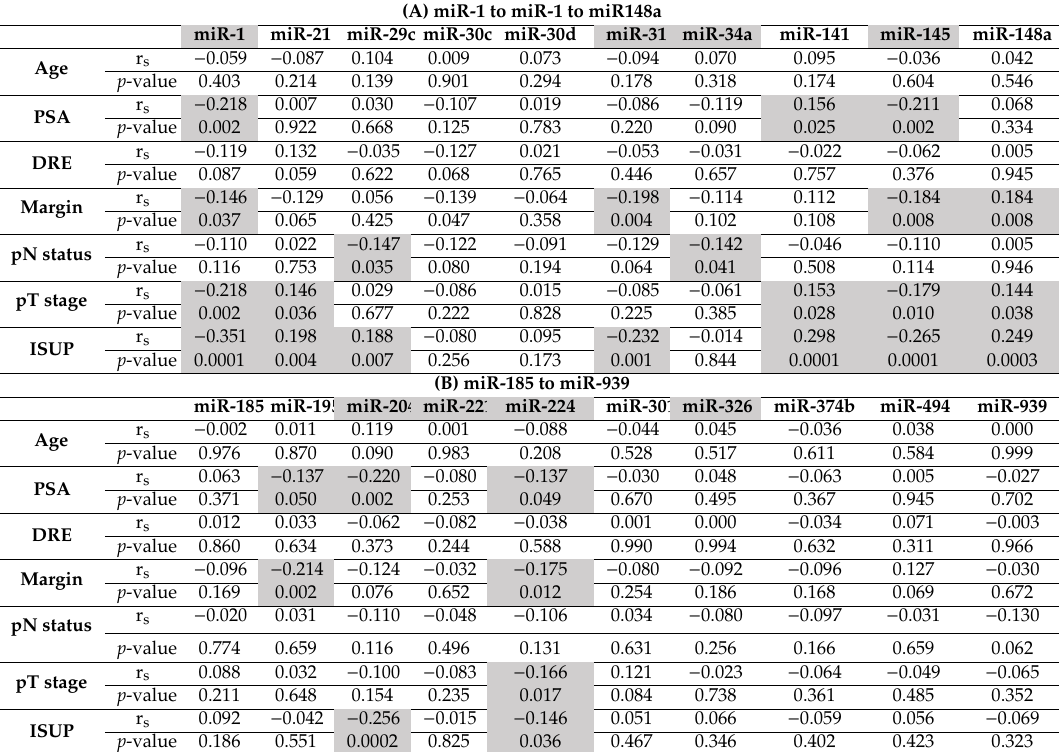
Table 3. Spearman rank correlation coe ffi cients between various clinicopathological factors and the examined microRNAs in all tumor samples ( n = 206). The eight significantly di ff erentially expressed miRNAs, according to biochemical recurrence status, and correlations with p < 0.05, are highlighted in